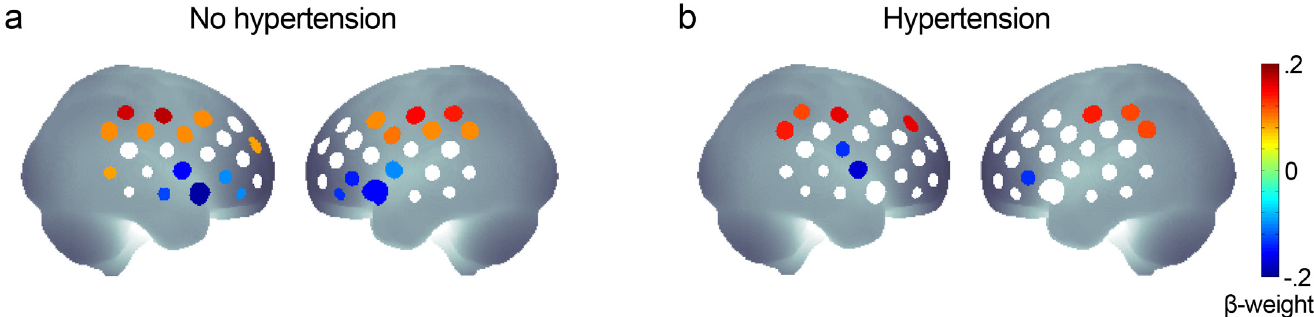
Fig 4. Standardized β -weights of the predictor age in channel-wise (FDR-corrected) multiple regression analyses of hemodynamic response amplitudes during phonological fluency in a) individuals without hypertension, and b) individuals with hypertension. Regression models included the predictors age, sex, years of education and task performance. Interaction analyses of factor age and hypertension were not significant.